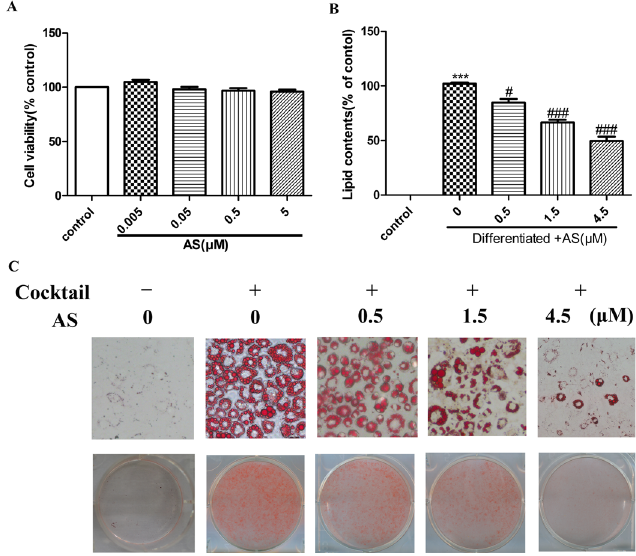
Fig 3. AS inhibits 3T3-L1 preadipocyte differentiation and fat accumulation. ( A ) Cell viability was assessed with the MTT assay24 h after AS treatment. ( B ) Relative lipid content. ( C ) Inhibition of fat droplet formation by AS. 3T3-L1 cells were seeded and induced to differentiate for 8 days with or without AS in 6-well plates, then stained with Oil Red O and imaged by light microscopy (200×). Values are expressed as mean ± SEM. Significant differences were observed between the untreated and differentiated control cells. * P < 0.05, ** P < 0.01, ** P < 0.001 vs. AS-treated cells; # P < 0.05, ## P < 0.01, ### P < 0.001 vs. differentiated control